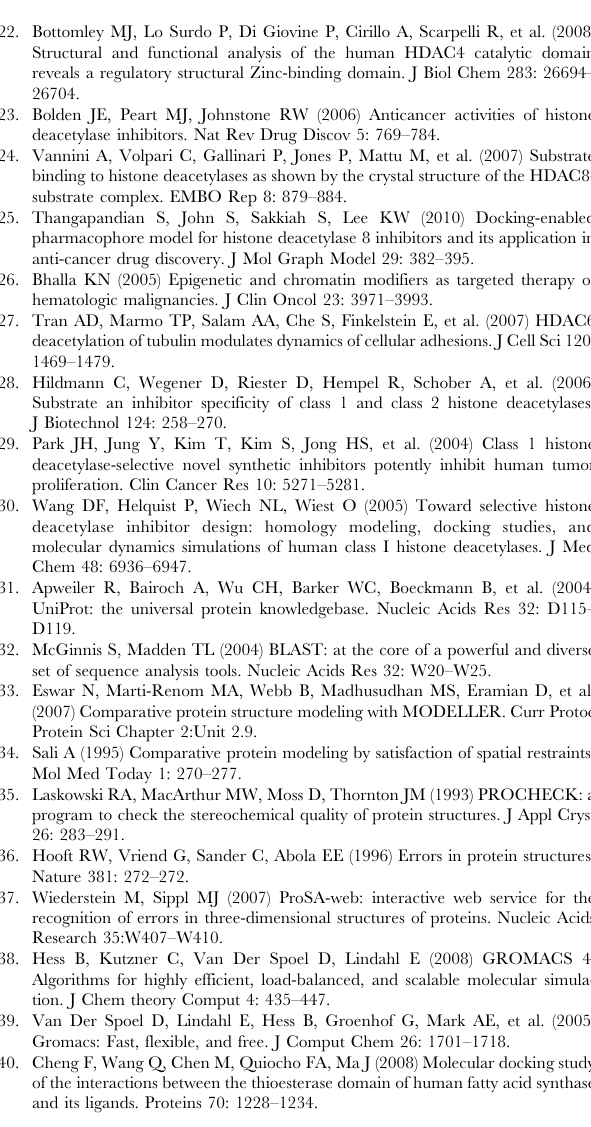
Figure S7 Molecular docking results to validate the structures obtained from MD simulations. Four crystal structure conformations of three different inhibitors at the active sit of HDAC8 were compared with the molecular docking results. (A) co-crystalized SAHA (PDB code: 1T69) is in blue and the docked conformation in pale green color, (B) co-crystalized V5X (PDB code: 2V5X) is in white and the docked conformation in dark salmon color, (C) co-crystalized TSA (PDB code: 1T64) is in violet and the docked conformation in yellow color, (D) co- crystalized TSA (PDB code: 3F0R) is in lime and the docked conformation in yellow color. Figure S8 Secondary structural changes observed in HDAC8 and 10 systems. (A) Initial and average structures of HDAC8 are shown in cyan and pale green colors, respectively. (B)